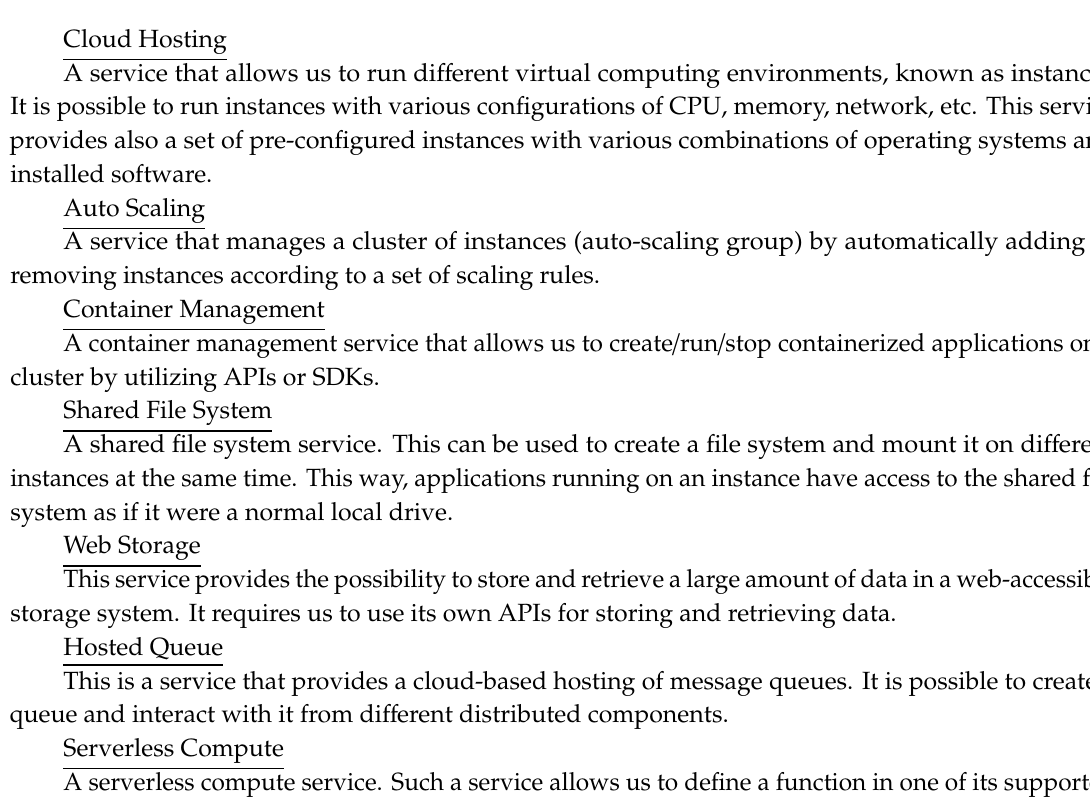
Figure 7. VLab Cloud Deployment.